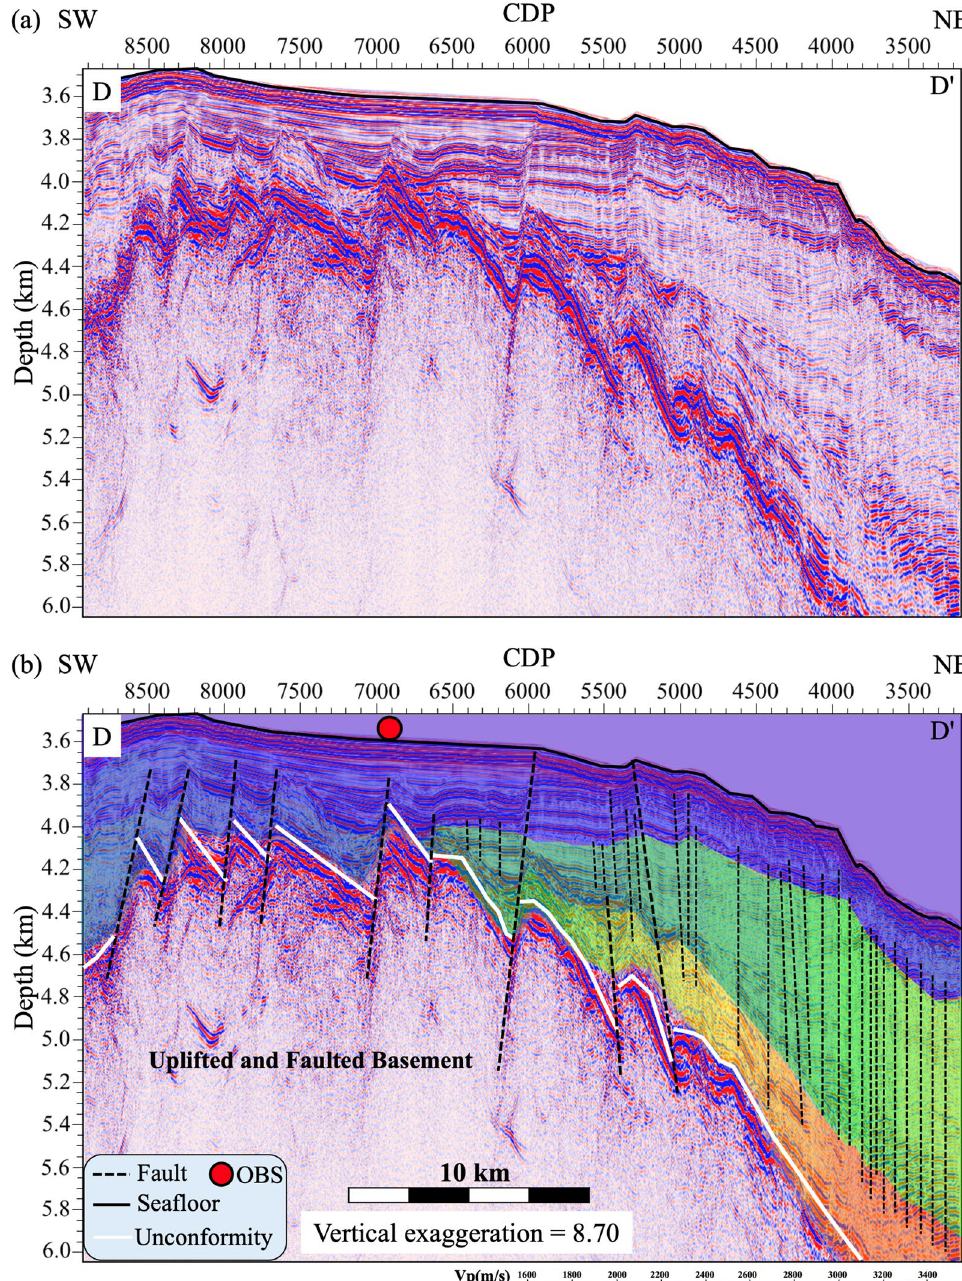
Fig. 5 a The uninterpreted PSDM section and b the horizontal velocity model is superimposed on the PSDM section with interpretations across the Nanao Basement Rise along Line DD’ (Fig. 2) of